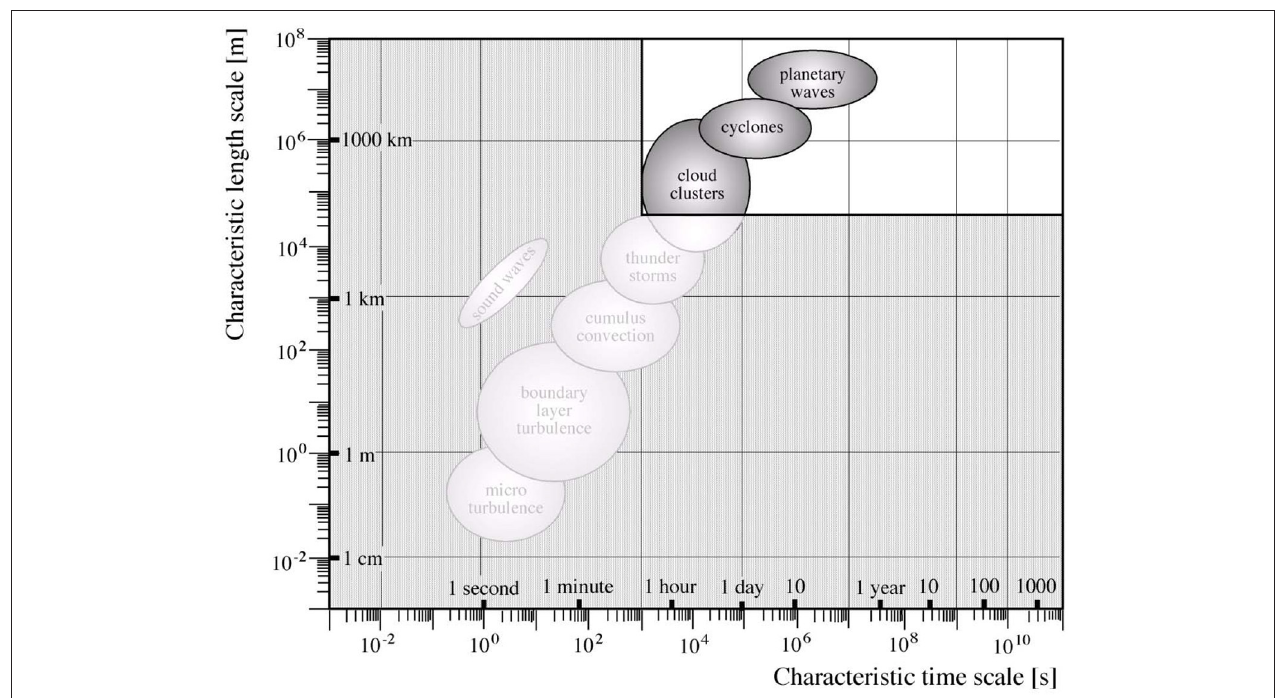
FIGURE 1 | Distribution of atmospheric dynamical processes in the weather system, sorted according to spatial and temporal scales. The stippled part, with small scale processes, is usually not explicitly described in models of the system, but “parametrized.” von Storch and Zwiers (1999); © Cambridge University